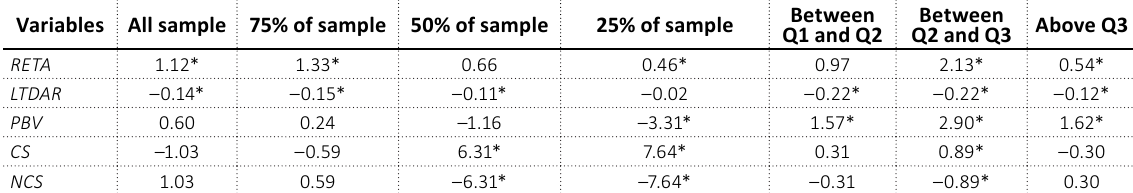
Table 2. Mean difference test Variables All sample 75% of sample 50% of